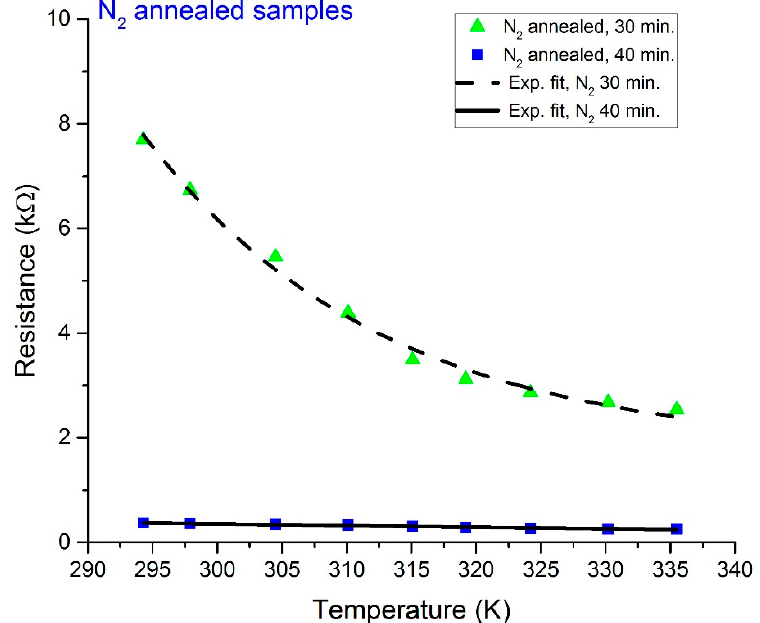
Figure 3. Measured resistance versus temperature for N 2 -annealed resistive thermometers.